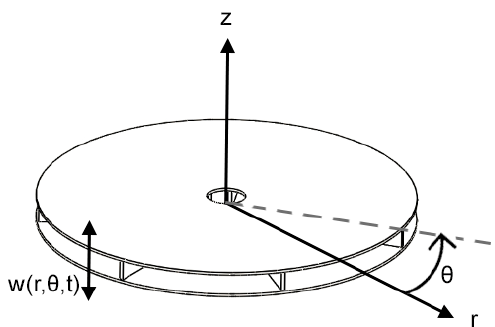
Figure 3. Coordinates for a generic disk-like structure.